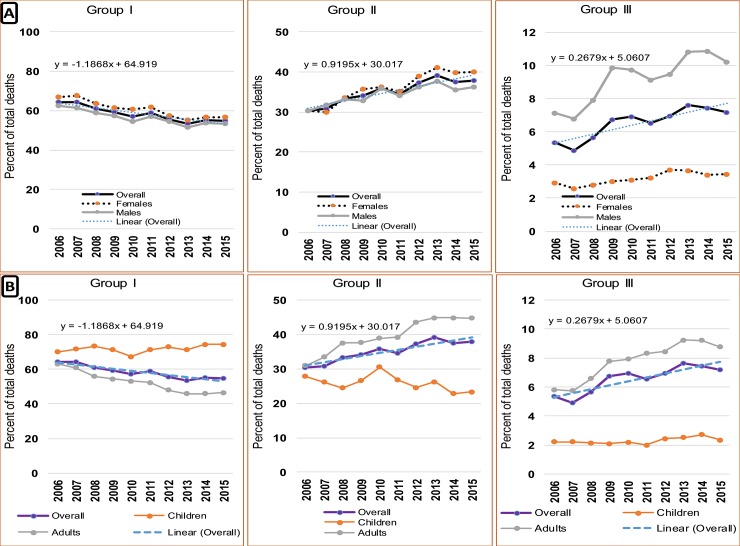
The annual pattern of causes of death by (A) sex; and (B) children and adults. The equation is for a trend-line indicating the slope and intercept over years.